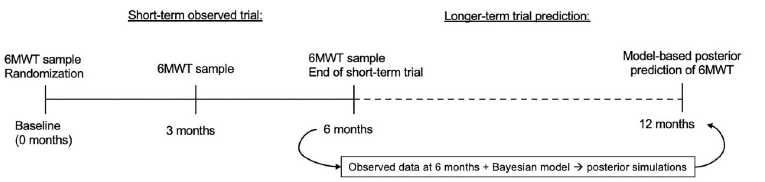
Fig 1. Overview of the Bayesian early decision-making framework. Individual 6-minute walk test (6MWT) samples were simulated to represent data from a short-term Duchenne muscular dystrophy (DMD) clinical trial. At completion of the trial, Bayesian model-based methods were applied to make long-term projections about the outcome at 12 months. The Bayesian model included prior natural history of the 6MWT in DMD boys.